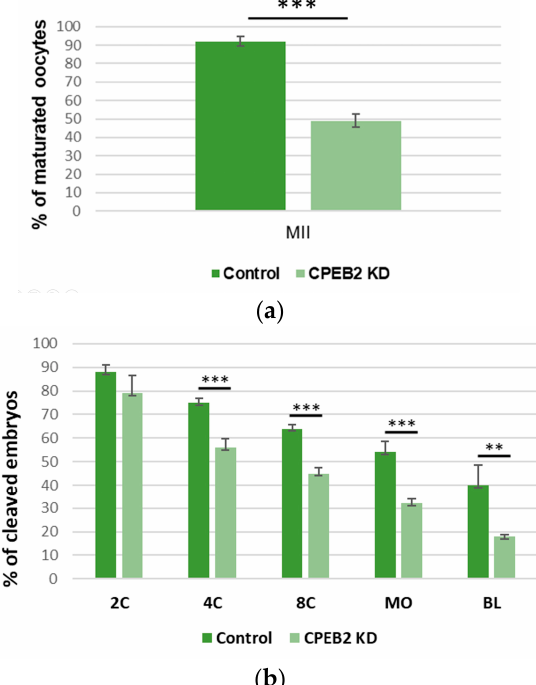
Figure 8. CPEB2 knockdown by dsRNA resulted in a decrease of properly matured oocytes and properly developed blastocysts. ( a ) The effect of CPEB2 KD on porcine meiotic maturation. ( b ) The effect of CPEB2 KD on early porcine embryogenesis including pronuclear (1C), two-cell (2C), four-cell (4C), eight-cell (8C), morula (MO), and blastocyst (BL) parthenotes. Data are means ± SEM ( n = 4). Asterisks indicate statistical difference (** p < 0.01, *** p < 0.001). Morphological differences between the control and KD groups were also observed. Not only did the CPEB2 knockdown result in an effective decrease of the first polar body extrusion and blastocyst formation, but also the blastocysts from the CPEB2 KD group were significantly smaller than those in the control group (Figure 9).